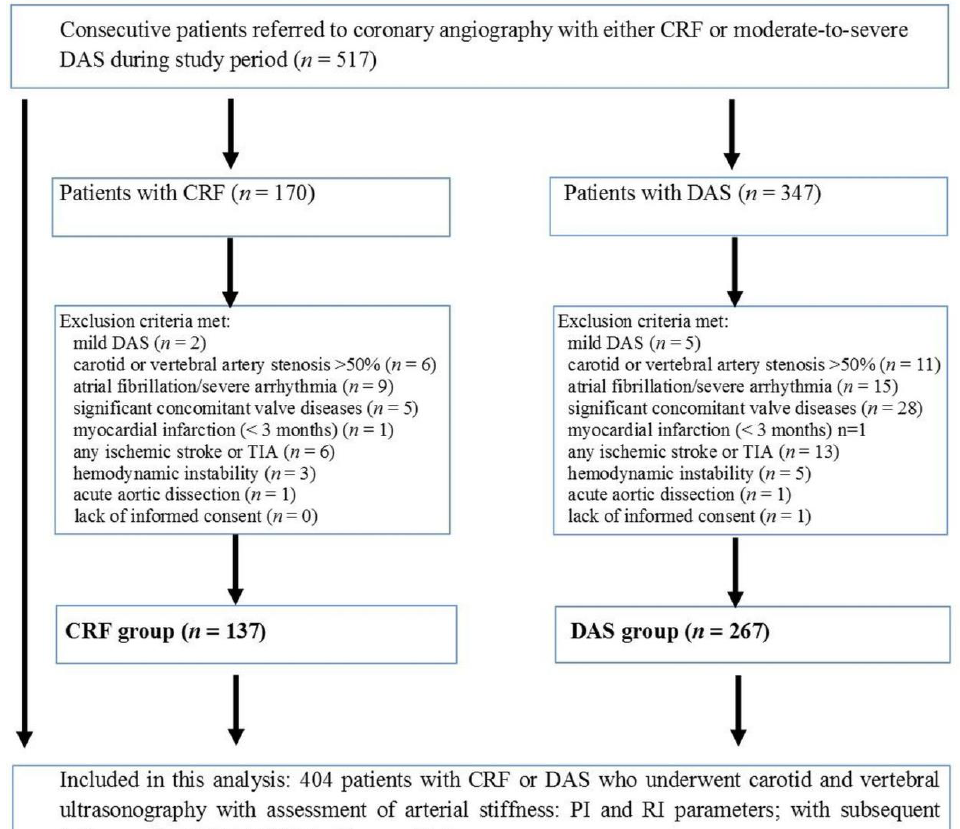
Figure 1. Study flowchart. CRF, cardiovascular risk factors; DAS, degenerative aortic valve stenosis; HF, heart failure; MACCE, major adverse cardiac and cerebral events; PI, pulsatile index; RI, resistive index .